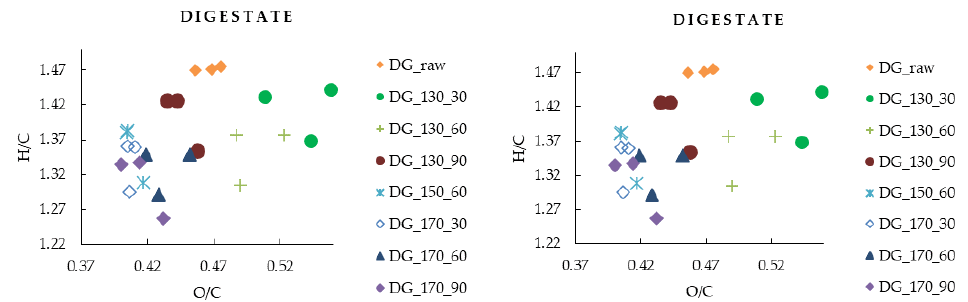
Figure A1. Raw materials used in this study: softwood-based forest residue (FR) and digestate (DG); left pictures: samples as provided; right pictures: samples as dry material.